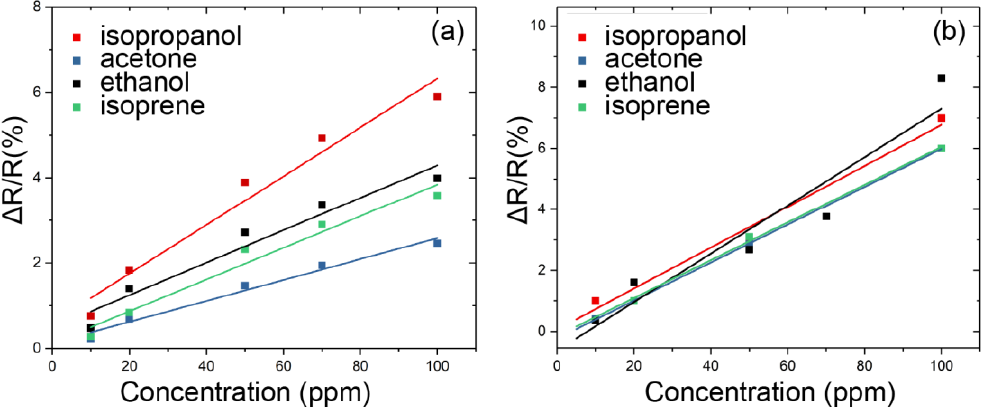
Figure 9. Fitting curves of the ( a ) MWCNTs and ( b ) PEG/MWCNTs sensor response as a function of VOCs concentration (10–100 Figure 8. Sensor response comparison of ( a ) MWCNTs and ( b ) PEG/MWCNTs for various VOCs and water vapors.